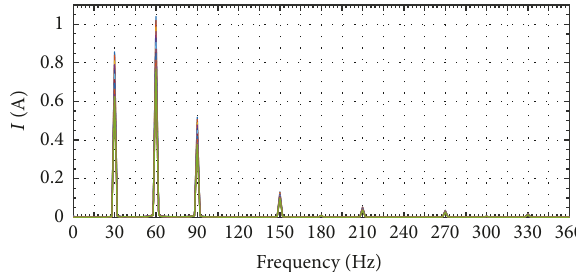
Figure 7: Output current waveforms of microinverter during burst mode (1 charging cycle) at different inputs.